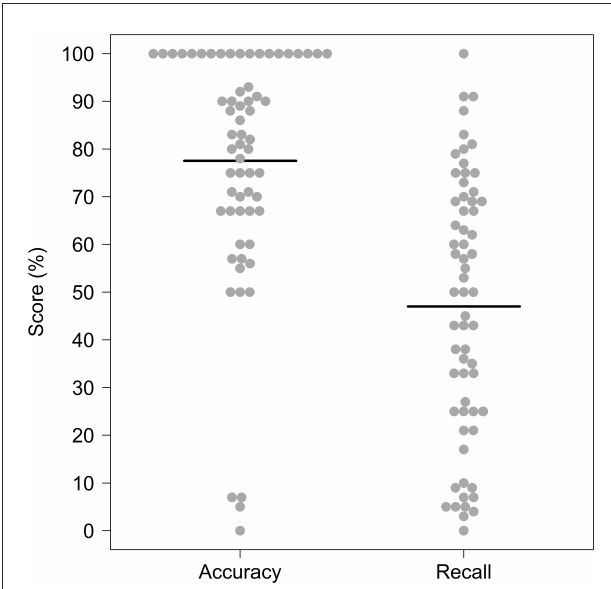
FIGURE2 Comparison of distributions of participants’ ( n = 63) accuracy (i.e., number of sheep they marked as lame that were actually lame) and recall (i.e., number of the total lame sheep in the flock that they marked) scores. Individual participant data points are jittered using the beeswarm algorithm (R Package “beeswarm”) and mean recall scores are plotted as bold horizontal lines underneath the data